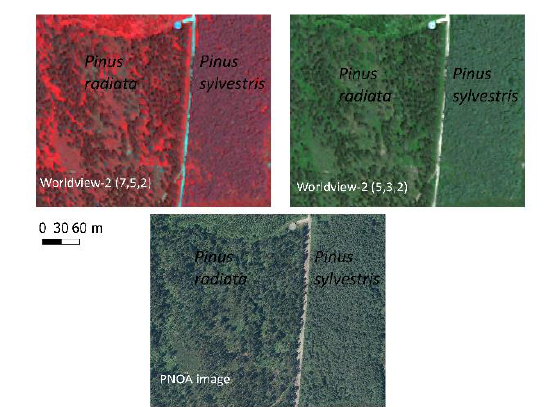
Figure 4. Detail of Worldview-2 images of Pinus spp. stands. Reference image PNOA (IGNb, 2021).